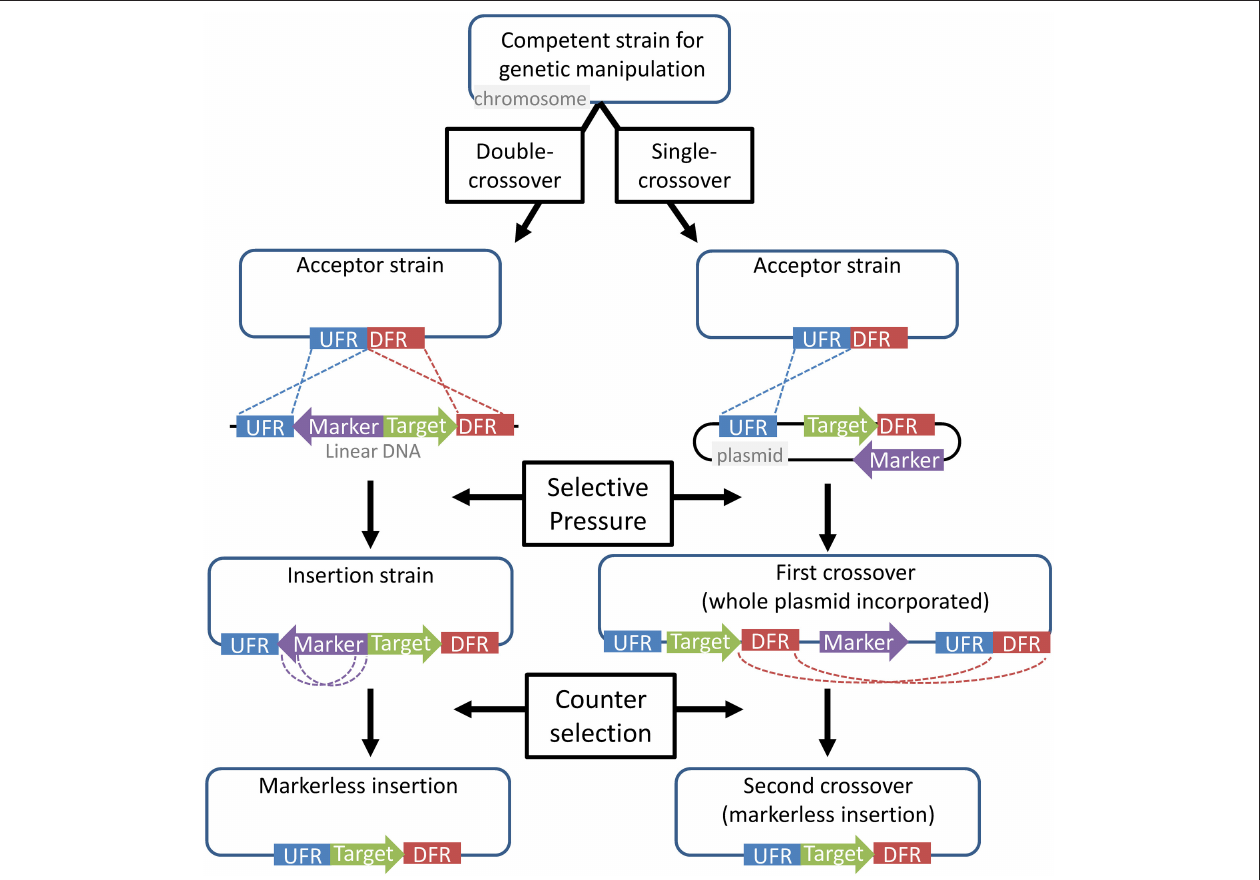
FIGURE 2 | General strategy for chromosomal gene insertion, used in most of the organisms discussed here. Upstream flanking regions (blue) and downstream flanking regions (red) are used to direct DNA for the insertion of a target gene (green). A marker gene (purple) provides resistance to a selective pressure, such as the addition of an antibiotic or the absence of an essential nutrient. In the case of a single first-crossover (from a circular plasmid), counter-selection results in a second crossover with the other set of homologous regions, resulting the loss of the plasmid backbone. With double-crossover, short homologous regions flanking the marker allow its removal. In either case, counter-selection recovers a markerless acceptor strain that can be used for subsequent insertions. This method can also be used for gene